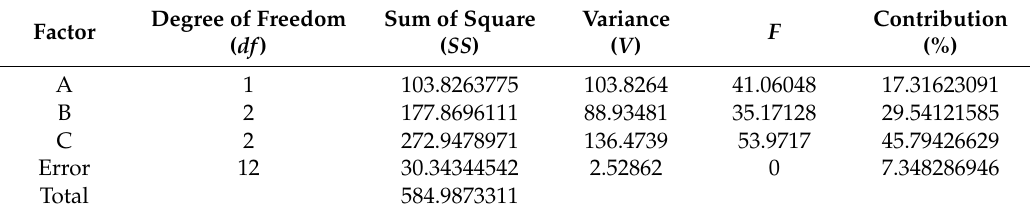
Table 5. Results of variance